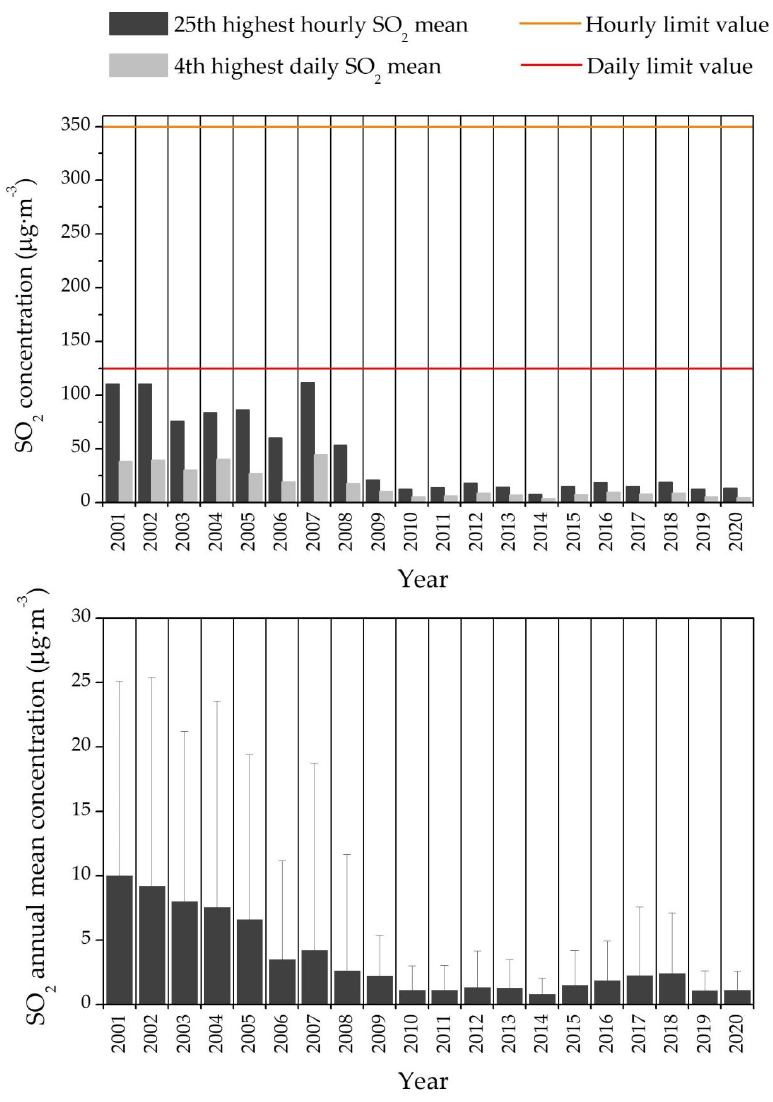
Figure 5. Levels of SO 2 in Seixal from 2001 to 2020: ( top ) highest hourly and daily means, ( bottom ) annual